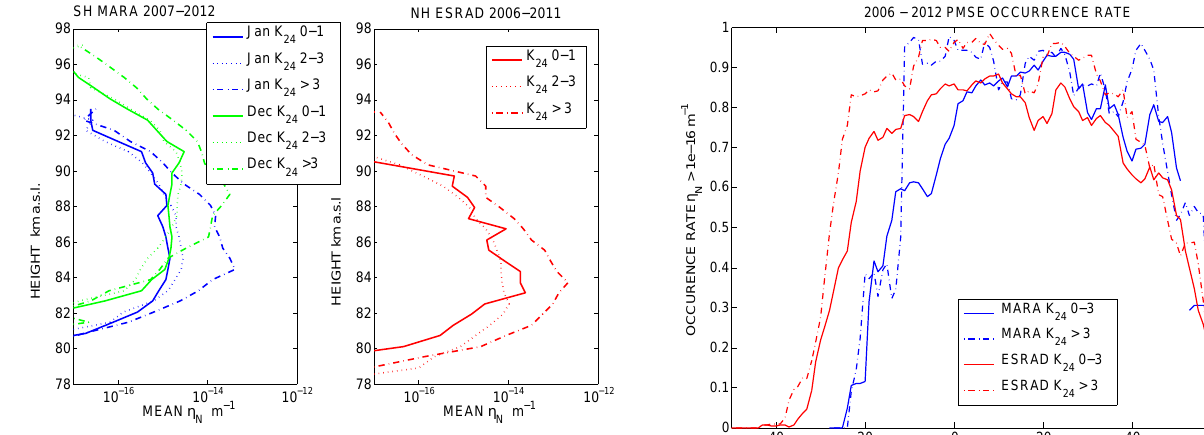
Fig. 6. Height profiles of mean PMSE volume reflectivity for dif- ferent levels of magnetic disturbance. Means are based on 1-h av- erages, the months of June and July at ESRAD, December and January at MARA (separately for each month).Values below η N = 10 − 16 m − 1 are set to zero before averaging.